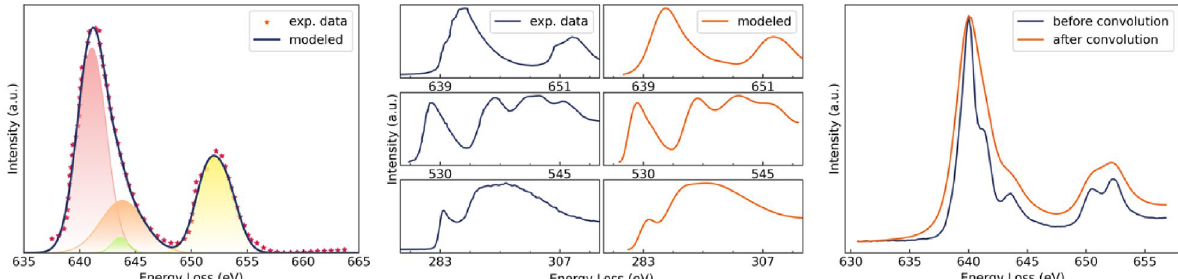
Figure 1. Ionization edge